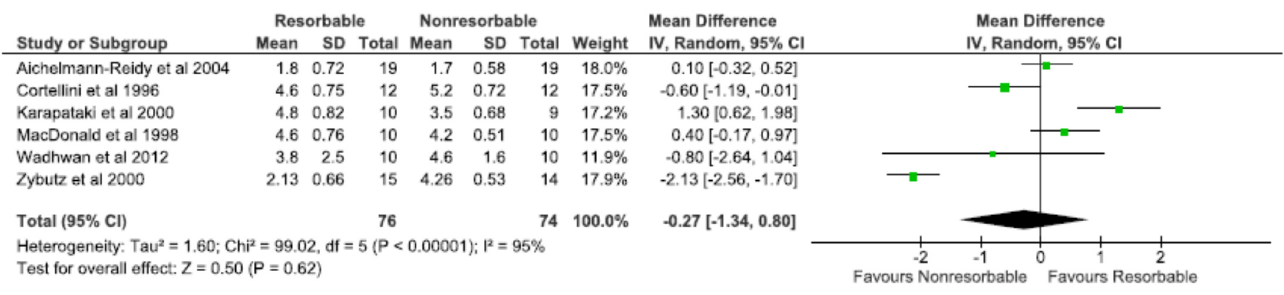
Figure 6. Meta-analysis of clinical attachment level (CAL) at all intervals (6–12 months).